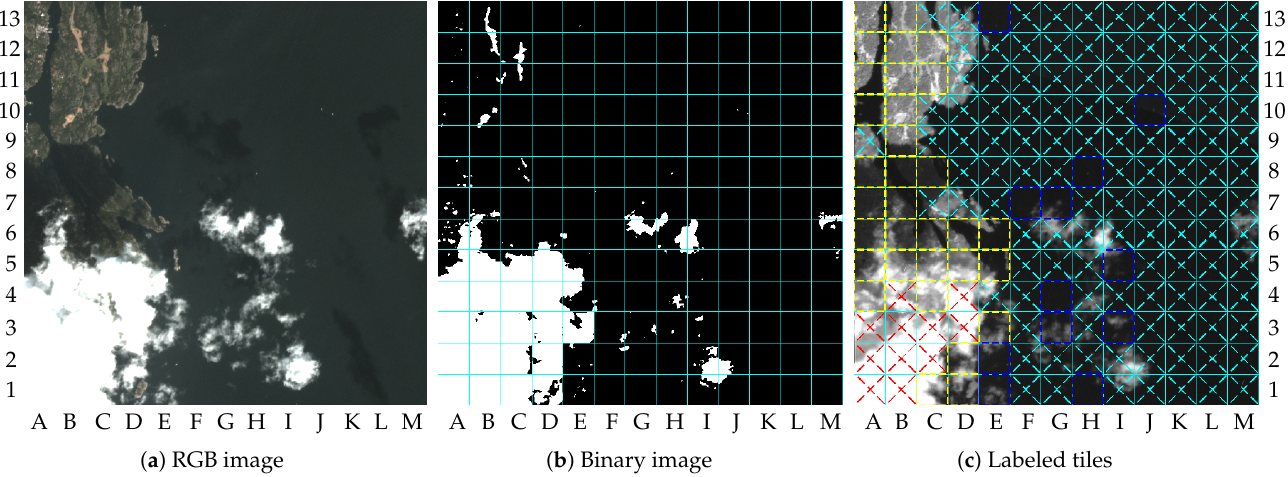
Figure 11. Results for image 9: ( a ) RGB image (truncated at 2000); ( b ) binary image; ( c ) labeled tiles (truncated at